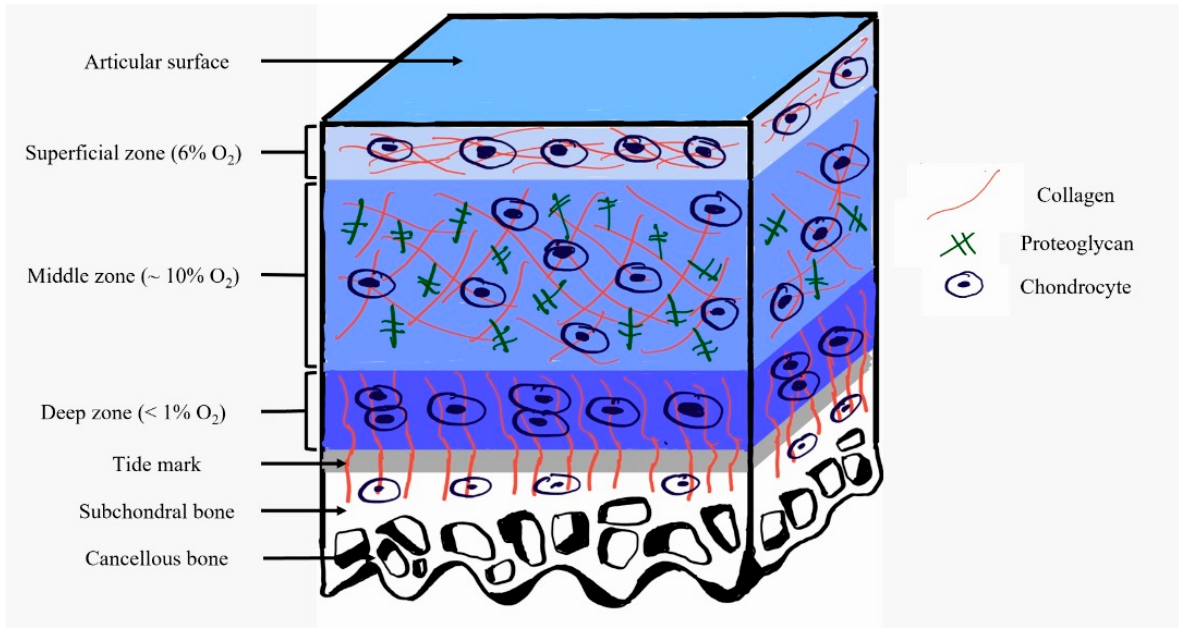
Figure 2. Variations in oxygen concentration in different regions of the articular cartilage.